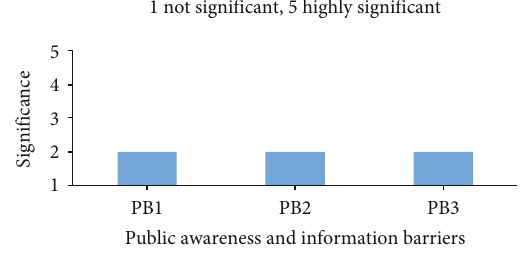
Figure 6: Signi fi cance of the public awareness and information barriers to the promotion of RE. PB1: local opposition to the development of projects; PB2: lack of dissemination and public awareness; PB3: lack of necessary scienti fi c and technical skills in the workforce.